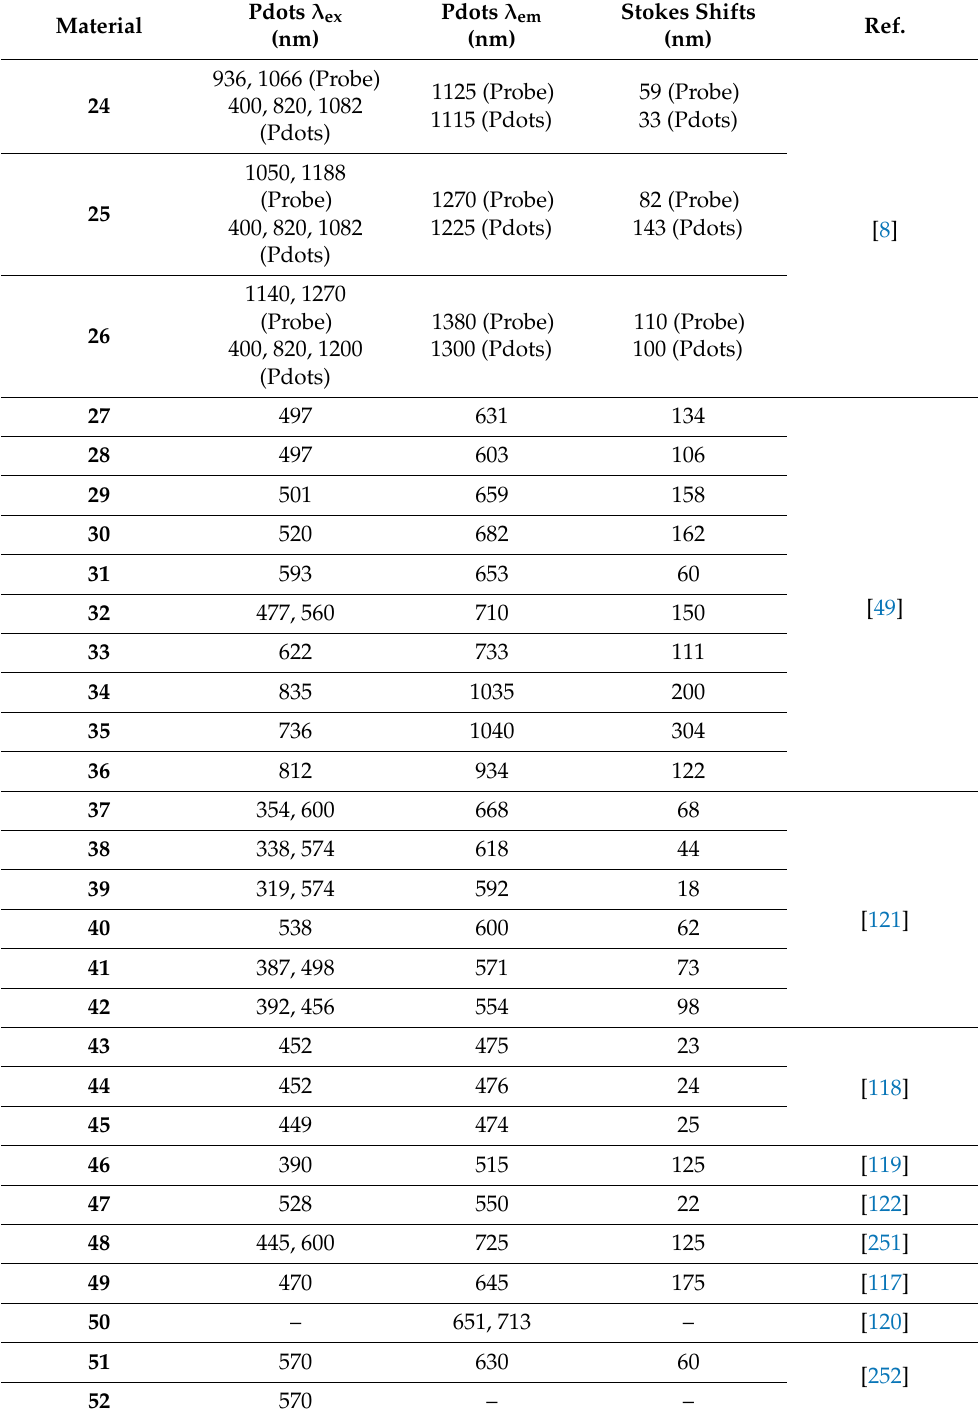
Table 5. Summary of the optical properties of photoluminescence polymer dots (Pdots) used for